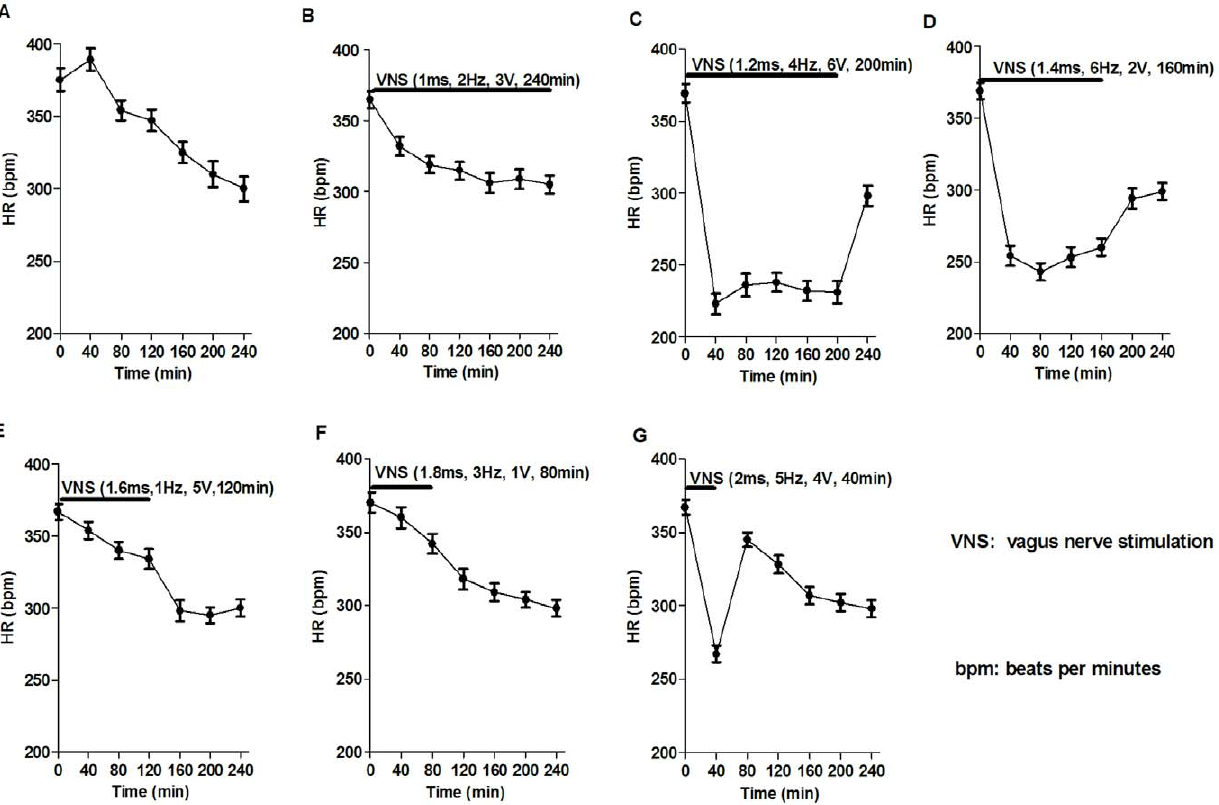
Figure 3. Time courses of heart rates (HR) change during acute myocardial infarction in rats with or without vagal simulation. The baseline values obtained just before LAD ligation are shown at time 0. (A) HR change in rats with AMI. Myocardial ischemia alone caused an increase initially then a progressively decrease in HR. (B–G) HR change in rats during AMI with vagal stimulations. HR was reduced from 1% to 45% compared to the baseline level. After the cessation of vagal stimulations, HR tends to increase back to the baseline level (n=12 for each